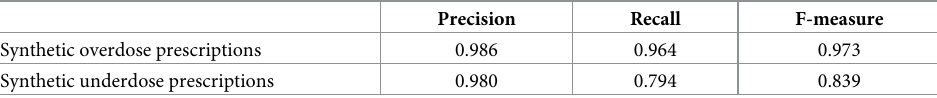
Table 4. Overall performance of OCSVM models for synthetic overdose and underdose prescriptions. Precision Recall F-measure Synthetic overdose prescriptions 0.986 0.964 0.973 Synthetic underdose prescriptions 0.980 0.794 0.839 Data represent the average values of 21